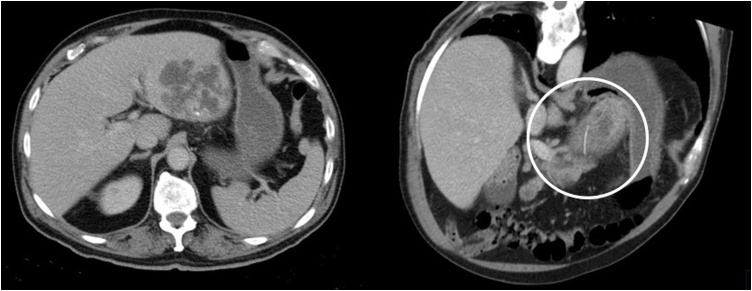
Abdominal CT scan at admission. A multiloculated hepatic abscess in the left lobe is noted with a high-density linear image suspected of being a foreign body.